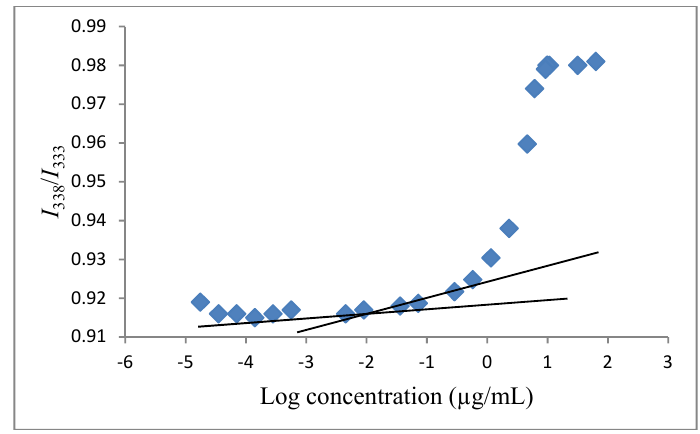
/ I (from pyrene excitation spectra) as a 338 333 conc. [Py] = 6.0 × 10 − 7 µM, λ = 390 nm, T = 37 2 em